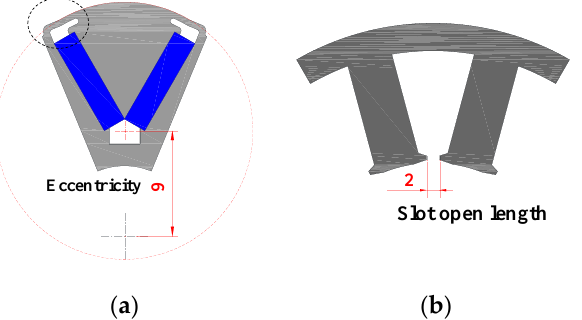
Figure 11. Design values of eccentricity and slot opening: ( a ) eccentricity; ( b ) slot opening.